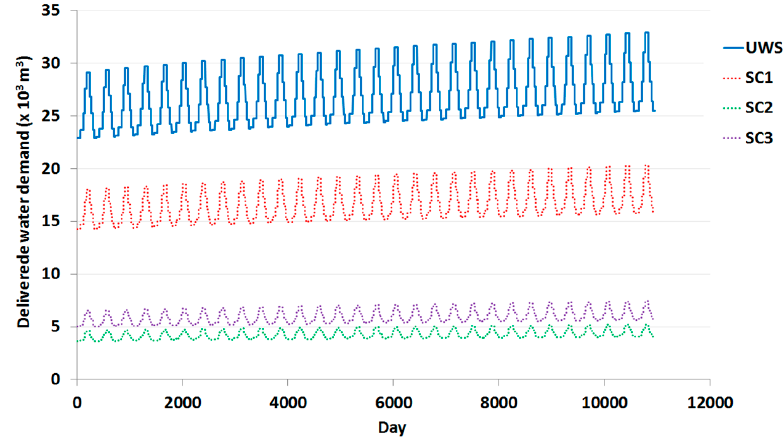
Figure 12. Total delivered water demand in the UWS and in the different SCs .